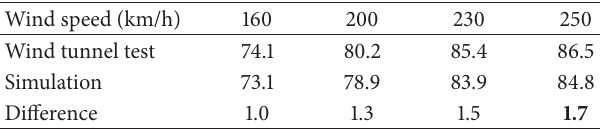
Table 3: Comparisons of 𝐿 𝑝𝑚 between simulations and experi-